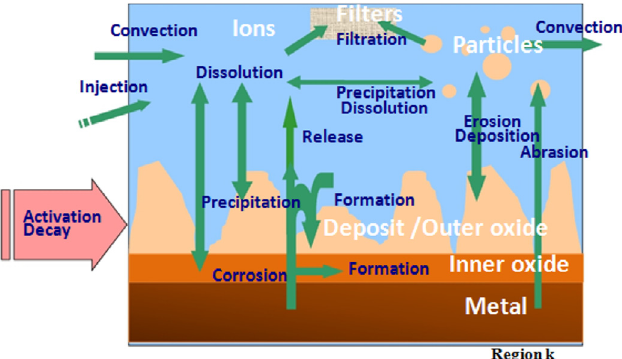
Fig. 2. Mass transfers between the different media in a